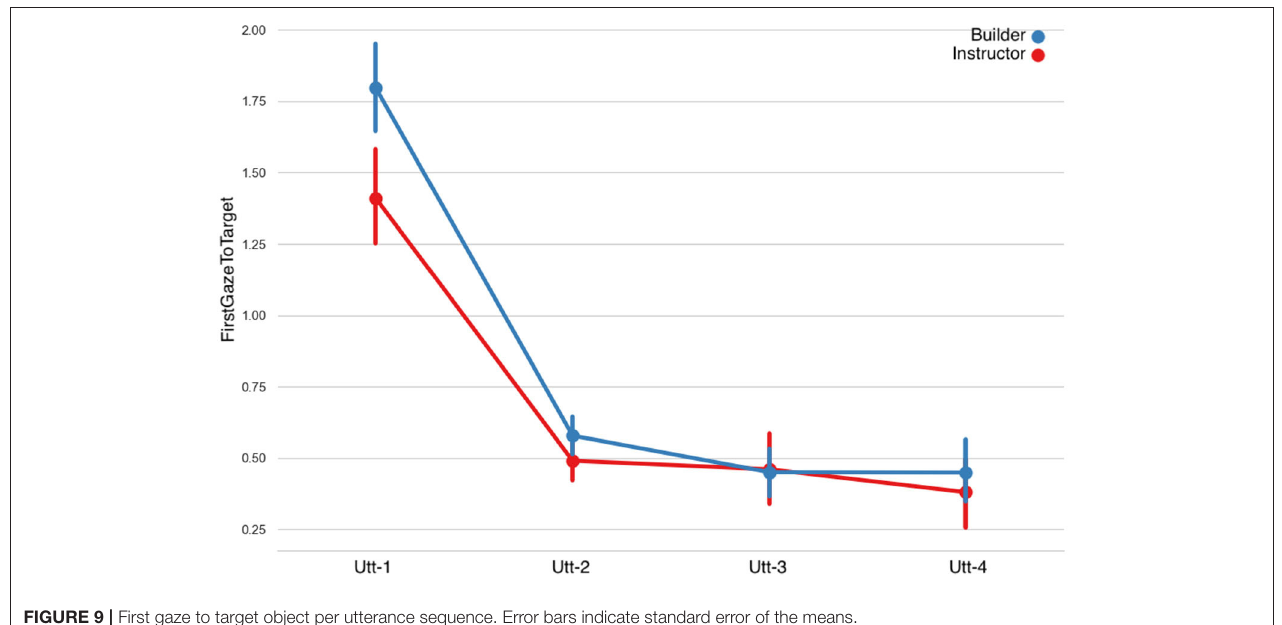
FIGURE 9 | First gaze to target object per utterance sequence. Error bars indicate standard error of the means.